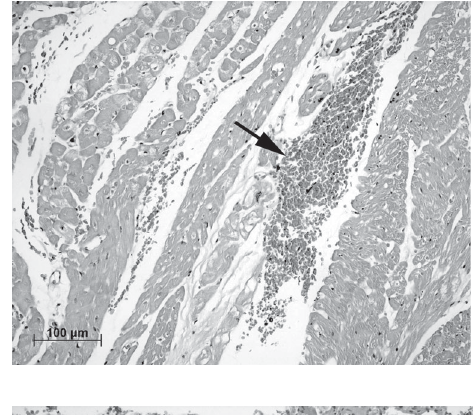
Figure 2. Photomicrography of a sub-pleural lung sample show- ing mild hemorrhage (arrows), characterized by erythrocytes in- side the alveolar spaces. Hema- toxylin-eosin; bar = 100